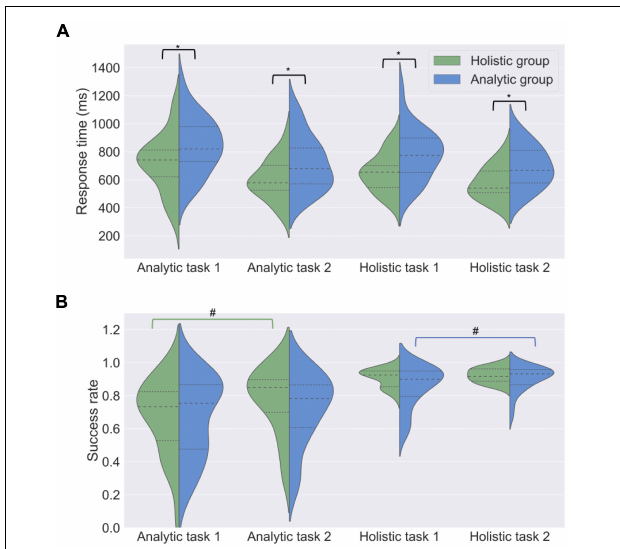
FIGURE 2 | Task performance in analytic and holistic groups. Distribution shapes, median values (dashed lines) and quartiles (dotted lines) are shown for response time (ms) (A) and success rate (B) in analytic and holistic tasks. Analytic participants solved the cognitive tasks slower than holistic participants. No difference in success rate was observed. T -tests for independent samples, * p < 0.05; # - paired samples t -tests, # p < 0.05.